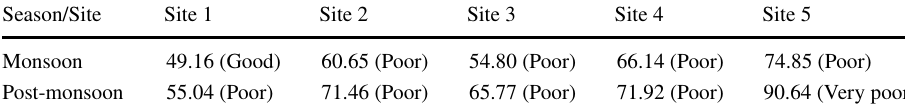
Table 6 Summary of water quality in monsoon and post- monsoon seasons